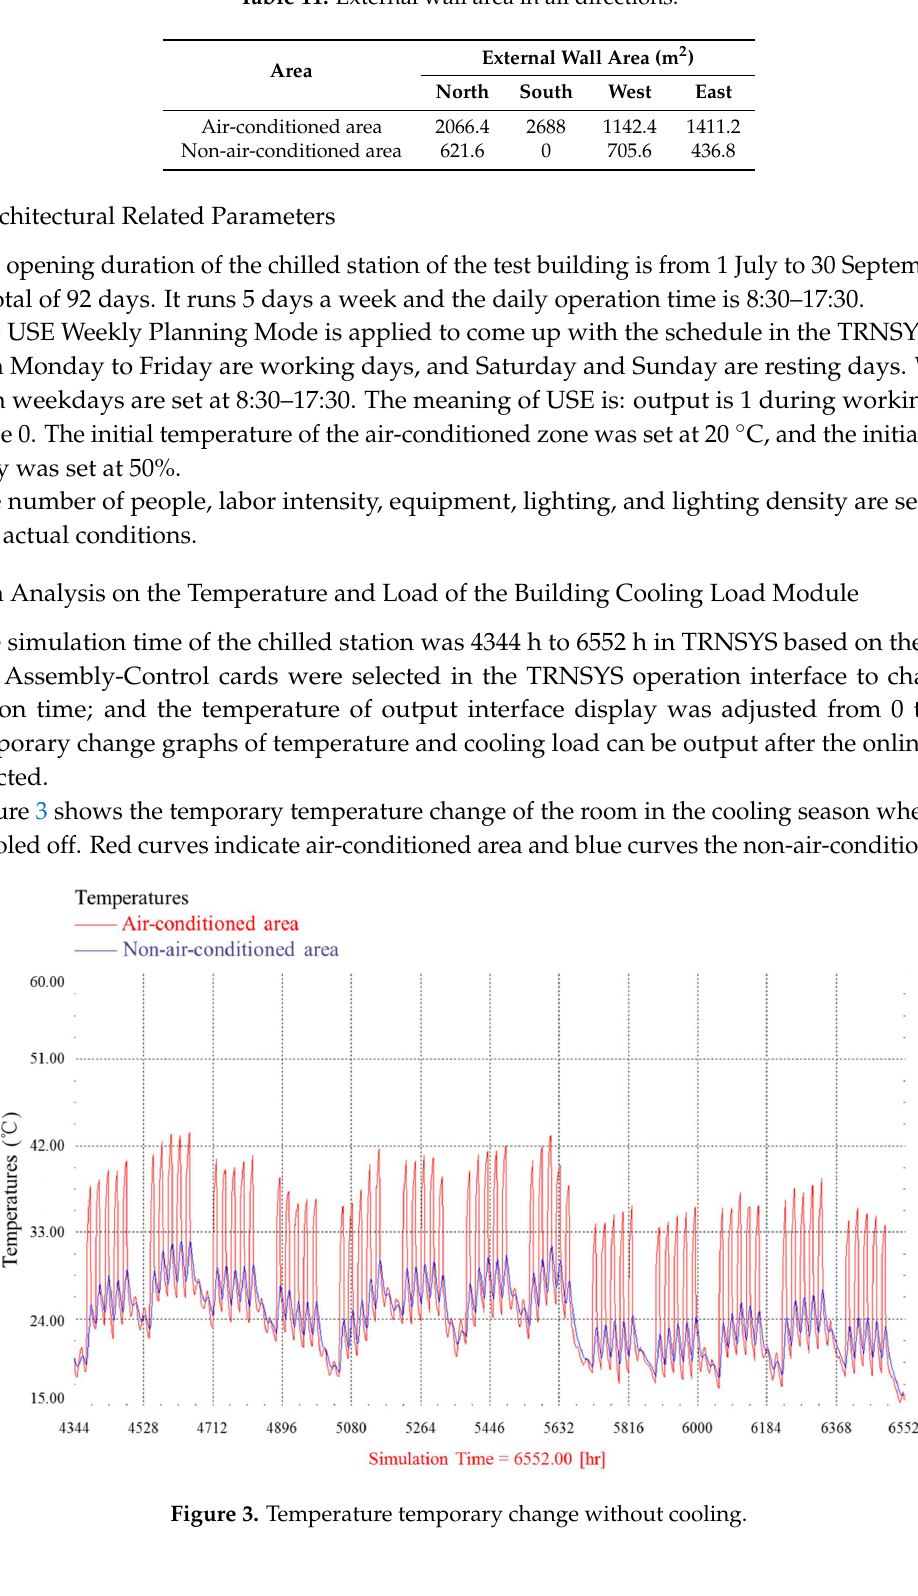
Table 11. External wall area in all directions.